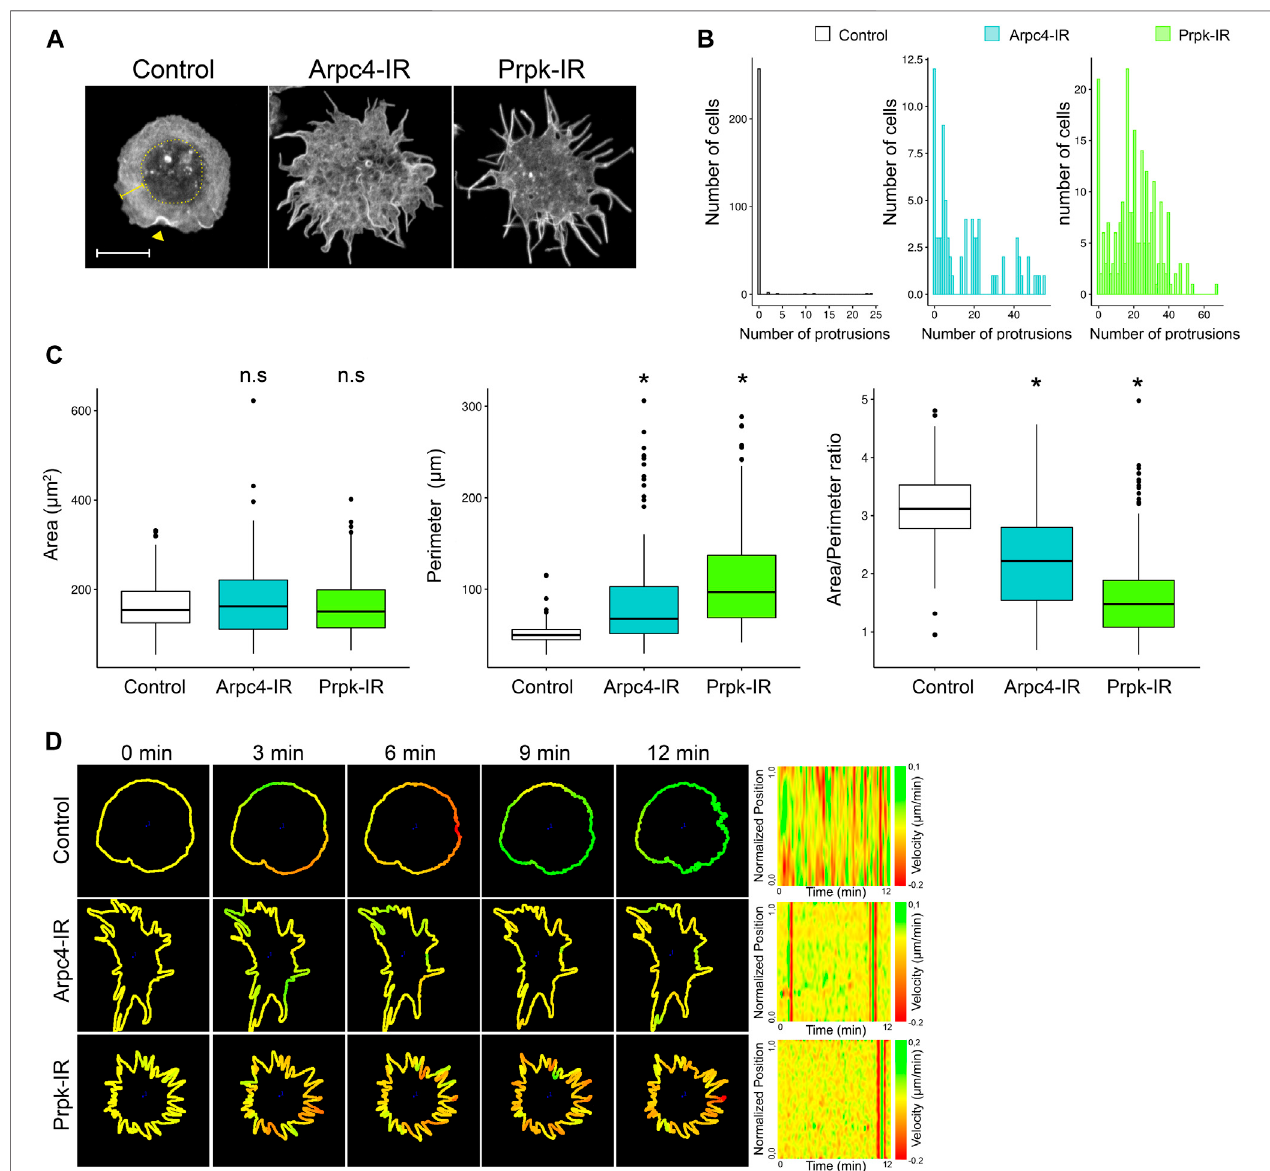
FIGURE 1 | Knockdown of Prpk alters cellular shape of hemocytes, similar to loss of function of the lamellipodia actin nucleator Arp2/3. (A) Confocal images of F-Actinstainedwithphalloidininprimarycultureofhemocytesexpressing:mCD8:GFP(Control),Arp2/3p20subunitRNAi(Arpc4-IR)andPrpkRNAi(Prpk-IR)usingCg- Gal4driverineachcondition.Thecellbodycorrespondstotheinnermostregionofthecell,enclosedinthedottedcircle,thelamellaisdepictedwithasquarebracketand thelamellipodiaisvisualizedbyactinruf fl es(arrowhead).Scalebar:10 μ m. (B) Quanti fi cationofthenumberofprotrusionsforeachcondition.Dataarepresentedas frequency of cells with protrusions. The Kolmogorov-Smirnov test was used for data analysis with a Bonferroni correction. Prpk-IR and Arpc4-IR hemocytes display a signi fi cantdifferenceinthenumberofprotrusionsinrelationtocontrolcells( p < 0.005);n ≥ 4(numberofcoverslipsanalyzed,quanti fi edmorethan150cellsineachcase). (C) Cellmorphologyquanti fi cationexpressedlikeArea,perimeterandArea/perimeterratioforeachcondition.Kruskal – Wallistestwasusedfordataanalysis,followedby a pairwise comparisons using Wilcoxon rank sum test. * p < 0.001; n ≥ 4 (number of coverslips analyzed, quanti fi ed more than 150 cells in each case) (D) Time-lapses of the actin cytoskeleton were performed co-expressing LifeAct-GFP with the different RNAi constructs using the Cg-Gal4 driver. Velocity maps (Normalized position vs. Time) of representative cells for each condition were generated using the ADAPT tool. Regions that span the membrane are assigned a green color, while regions of retraction of the membrane have a red color. The transition between green and red regions denotes the contractile activity of the plasma membrane.